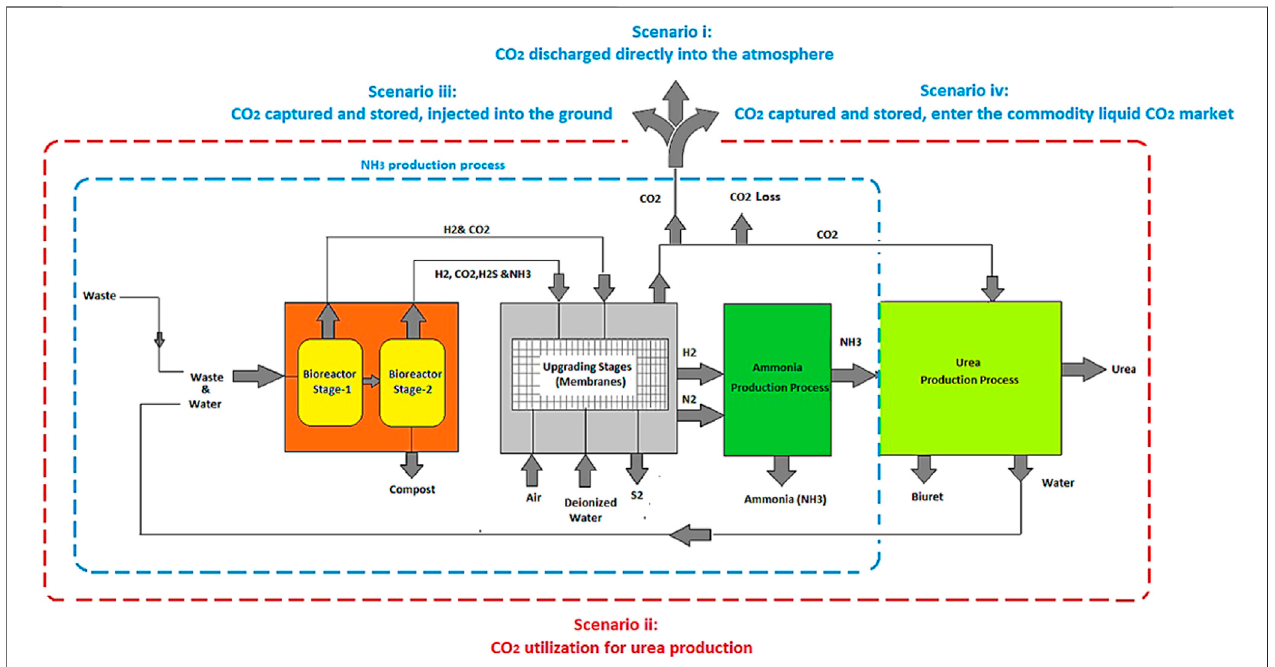
FIGURE 4 | A simpli fi ed process fl ow diagram of the proposed ammonia/urea production process.